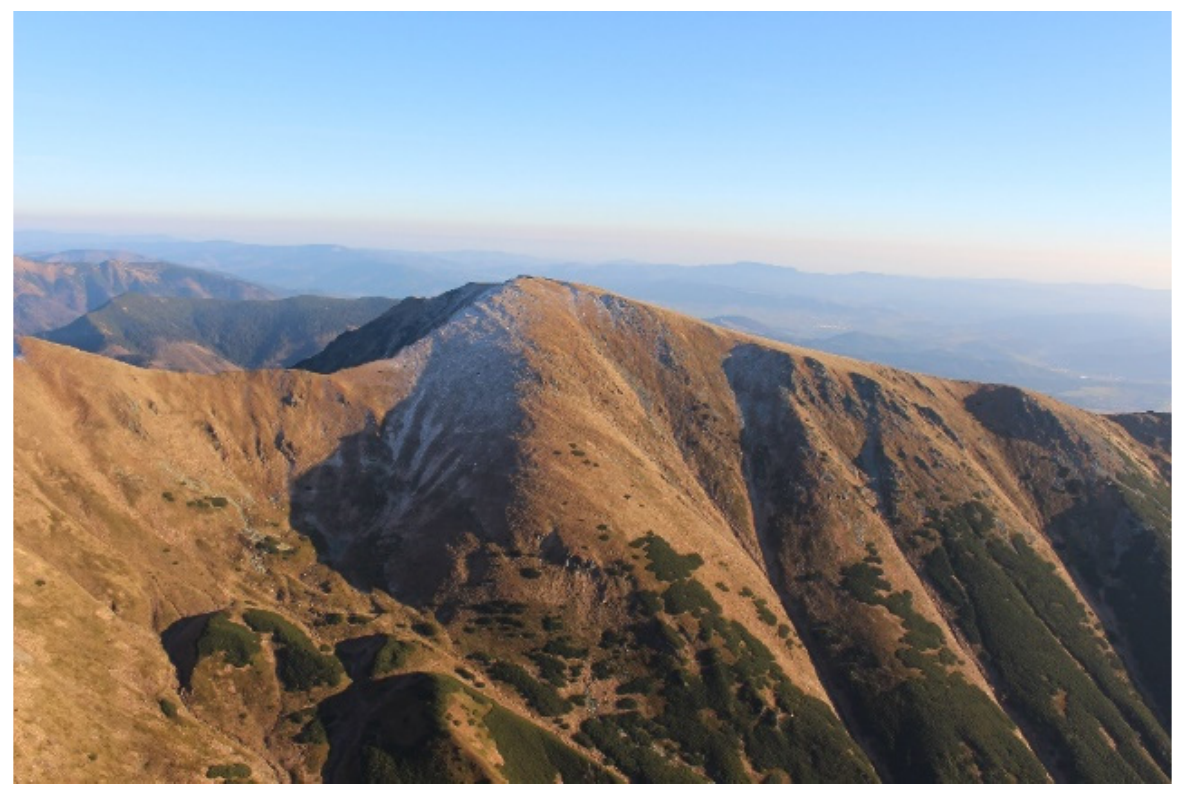
Figure 8. Anthropogenically created habitats at the end of Lomnistá Valley, where the first High Tatras chamois were released in the early 1970s (photo by P. Urban).